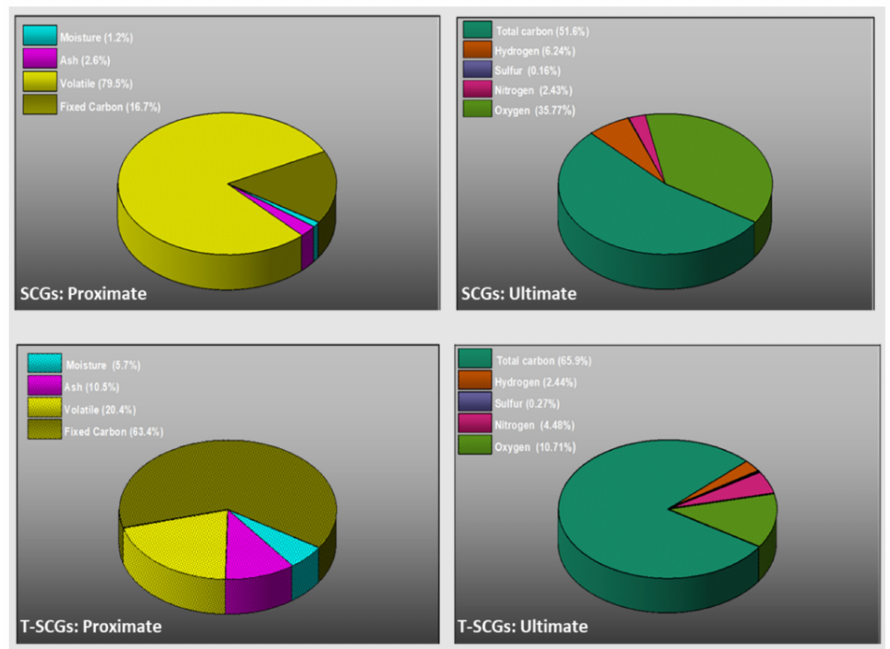
Figure 12. Proximate and ultimate analyses of SCGs and T-SCGs (Adapted from Biswal, et al. [58]). Reproduced with permission from